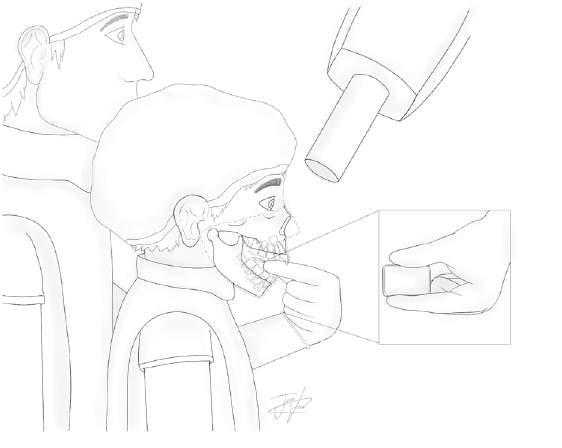
Figure 1. Representative illustration of modified periapical technique in an occlusal position for the maxilla.